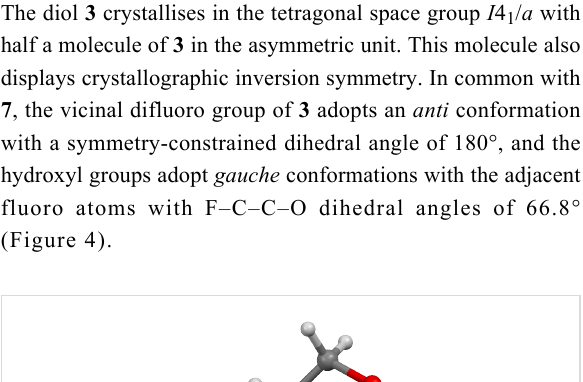
Figure 3: Crystal packing of 7 viewed along the b axis. Short contacts (see text) are shown in light blue.